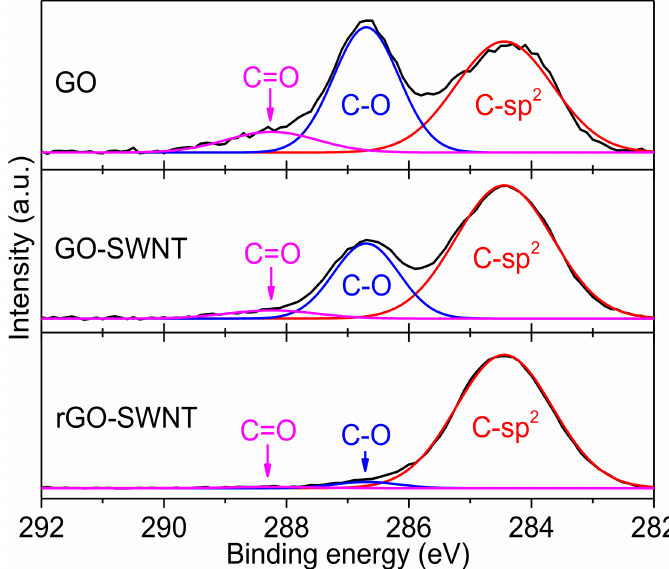
Figure 6. XPS C-1s spectra of GO, GO-SWNT (weight ratio of 10:1) and rGO-SWNT films. Peaks relate to different carbon bonds are